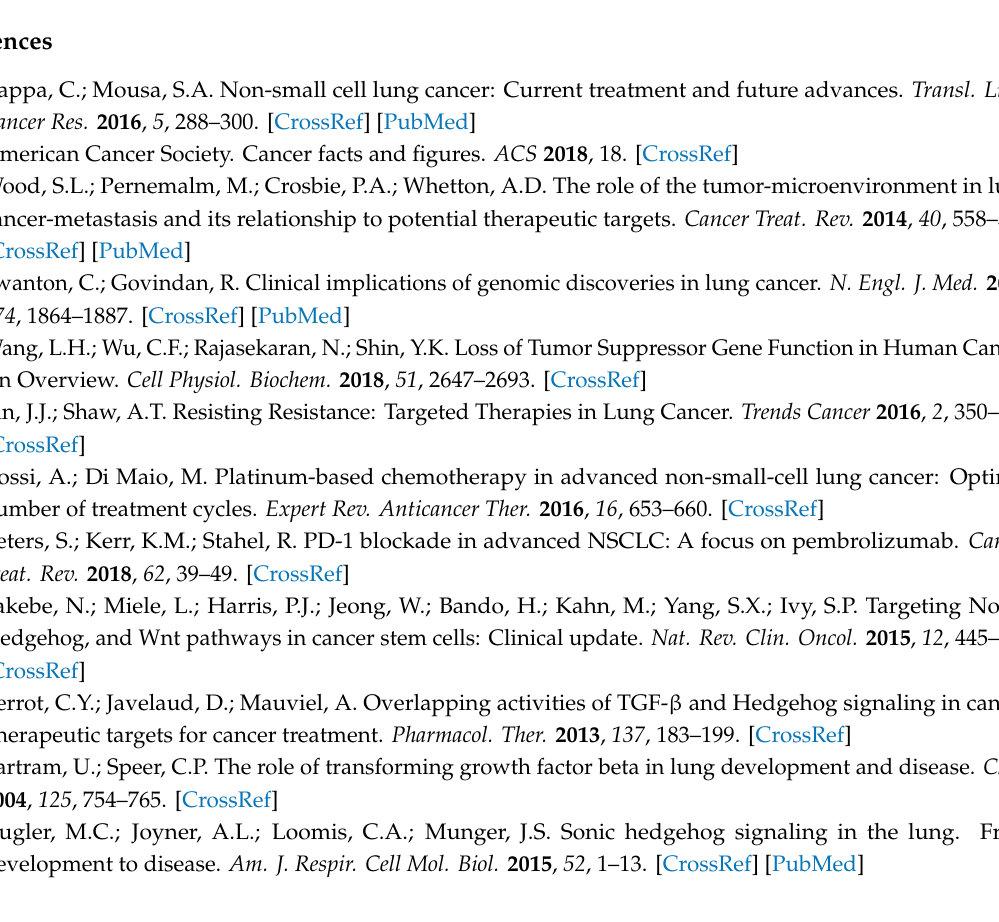
Supplementary Materials: Experimental write-up for the preparation of Oxy210, IC 50 determinations for Figures 4b and 7a–c, densitometry readings for Figure 11a are available online at http: // www.mdpi.com / 2073- 4409 / 8 / 10 / 1297 /